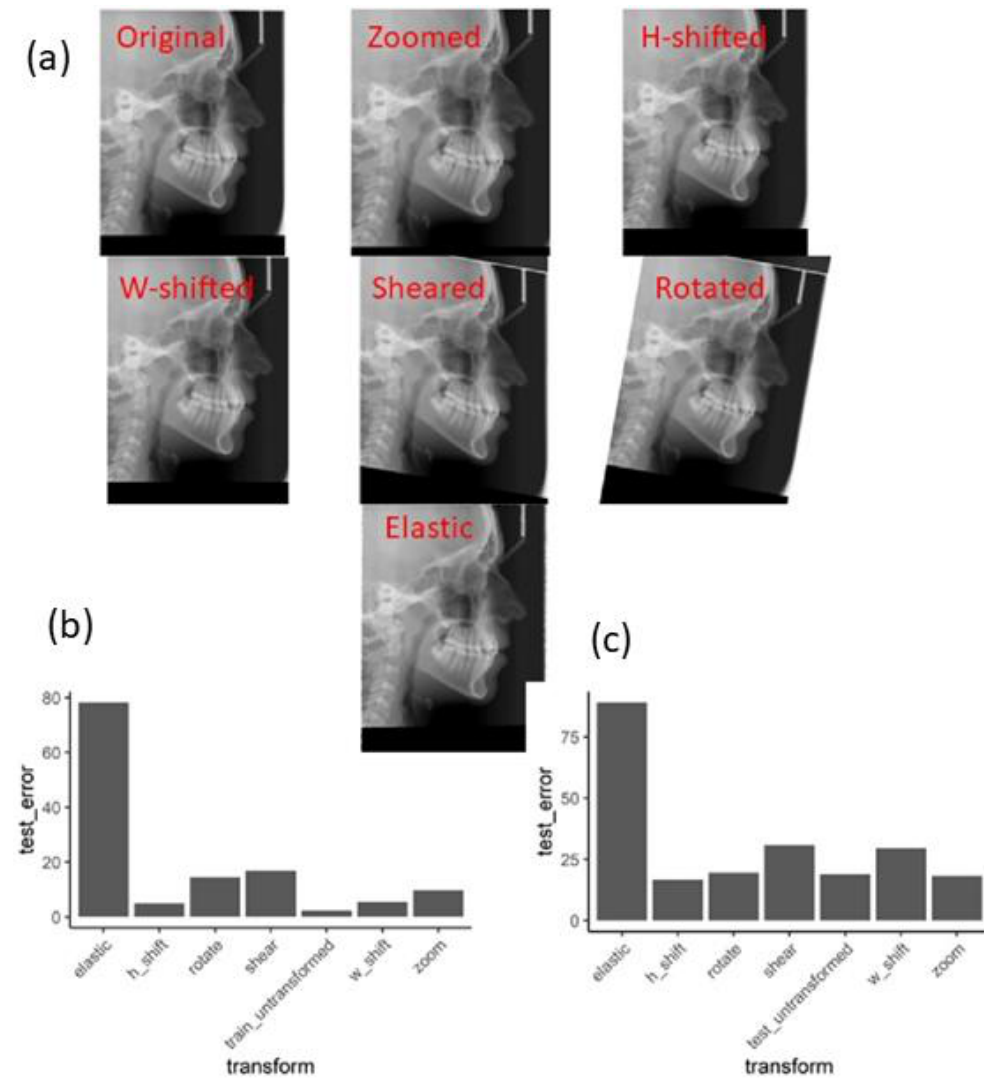
Figure 4. Evaluating different data augmentation transforms. ( a ) Sample images showing the results of image transformations. ( b ) A single model was trained on a set of 253 original (untransformed) images. The same training images were altered using different transforms. The performance of the original model was evaluated on these transformed images. The errors on the transformed images (train_untransformed) were of a similar magnitude to those on the real unseen images (test_un- transformed), thus confirming that the transformations added an appropriate amount of novelty to the images. ( c ) The performance of the original model was evaluated on different transformations of new unseen (test) images. The transformations did not overly distort the images since the perfor- mance on the transformed images was similar to the performance on untransformed images. For a model trained on original images only, Figure 4b shows the test errors obtained when predicting the landmarks of transformed images. Obviously, the error on the un- transformed trained images was negligible. After transforming the training images, the model was not able to perfectly predict the landmark positions, implying that these trans- formed images appear novel to the model. We see that the rotation and shear transfor- mations introduced the most novelty. The errors for the elastic transformation were higher by about one order of magnitude compared to the rest of the transforms.